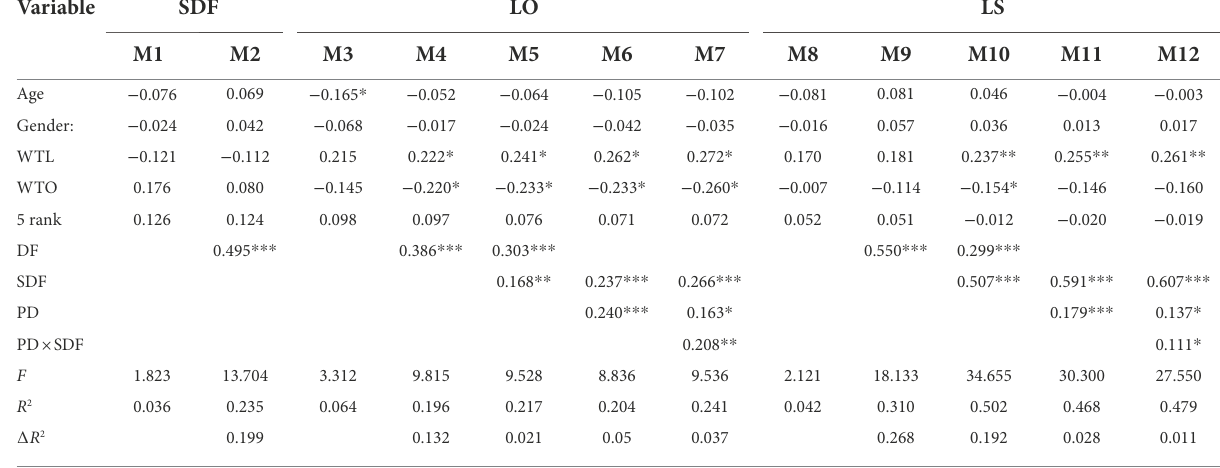
TABLE 6 Results of hierarchical regression analysis.